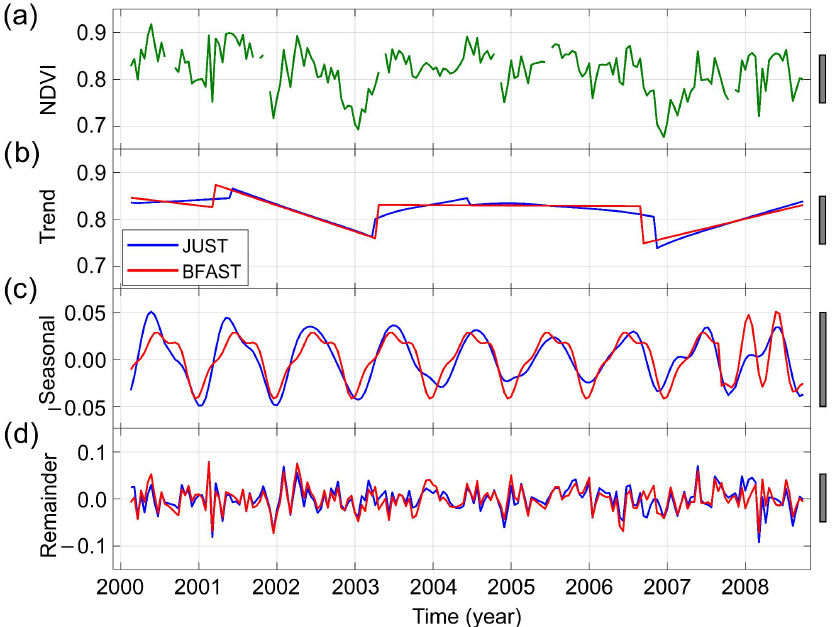
Figure 12. Decomposition of a NDVI time series (drought, insect attacks) with several missing values into trend, seasonal, and remainder components, see the caption of Figure 11 for more